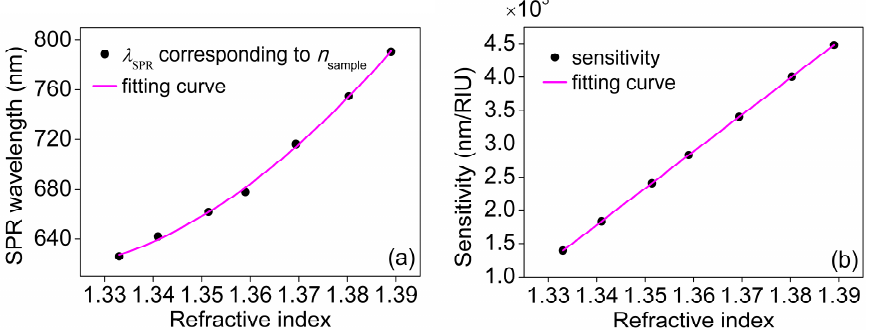
Figure 5. ( a ) Relation between the refractive index and the resonant wavelength; and ( b ) Relation between the refractive index and the refractive index dependent sensitivity. Table 1. Comparison of sensor parameters corresponding to refractive index of seven